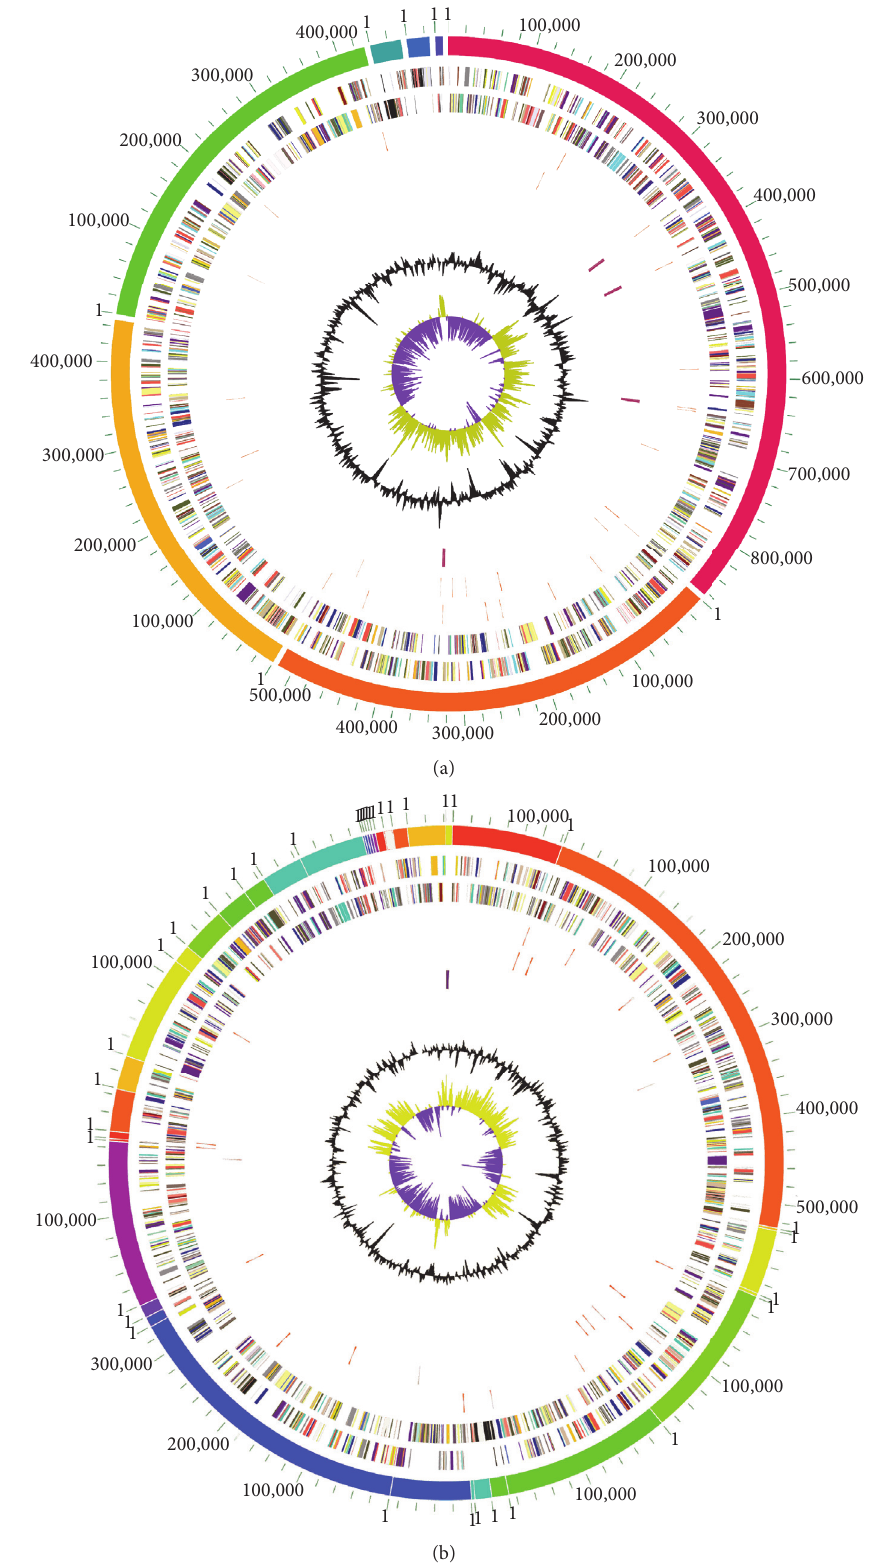
Figure 1: Circular genome maps of PmCQ2 (a) and PmCQ6 (b) from inside to outside indicate the following: Circle 1, G+C skew; yellow green, G+C skew > 0; purple, G+C skew < 0; Circle 2, G+C content (median represents the above average content, the outer circle is greater than the average content, and the inner circle is less than the average content); Circle 3, rRNA genes distribution represented in scaffold sequence; Circle 4, tRNA gene distribution represented in scaffold sequence; Circle 5, open reading frame (ORF) distribution, plus strand; and Circle 6, multiple scaffold